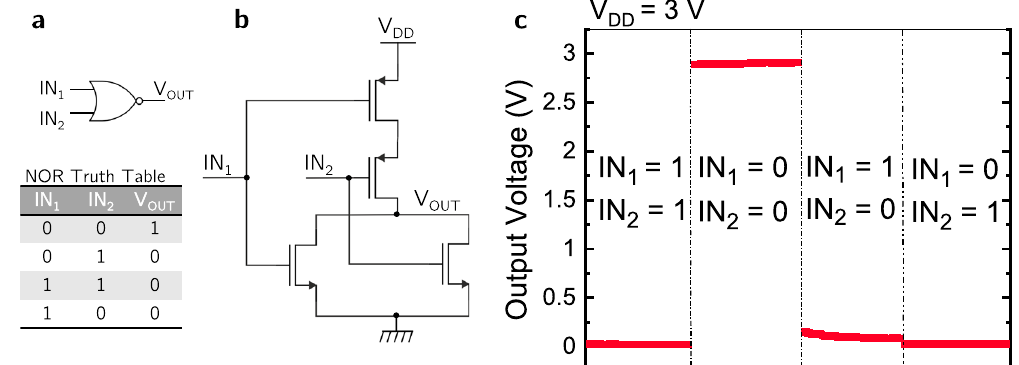
Fig. 3 Flexible NOR gate on paper. a Symbol of the NOR gate and its truth table. b Schematic of the complementary NOR gate. c Output characteristic of the fl exible NOR on paper with V DD = 3.0 V. The logic values ‘ 1 ’ and ‘ 0 ’ of the input signals (IN 1 , IN 2 ) correspond to input voltages of 3 and 0 V, respectively.